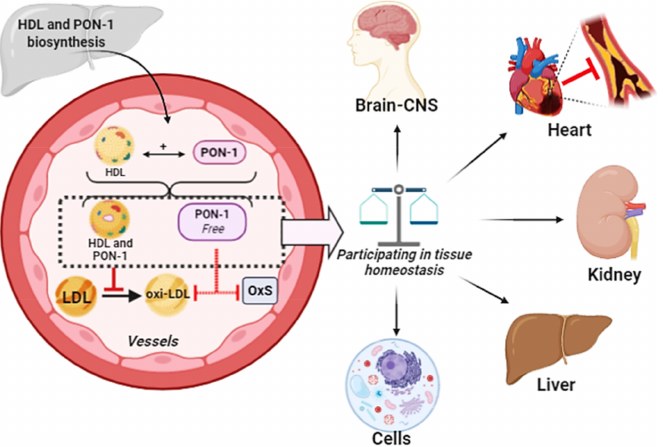
Figure 3. HDL biosynthesis occurs in the liver and in a small part of the intestine. Paraoxonase 1 (PON1) biosynthesis occurs only in the liver. After the formation of both HDL and PON1, they enter into the circulation. An association between HDL and PON1 can occur both in the hepatic circulation (to a lesser extent) and in the plasma. A small amount is free PON1, which do not adhere to any lipoprotein. An important function of PON1 is to prevent oxidation of both HDL and LDL, through the hydrolysis of reactive compounds. Oxidized LDL (ox-LDL) is pro-inflammatory and atherogenic. PON1 is carried to the tissues by HDL, where it performs its function as an antioxidant enzyme. In addition, the portion of free PON1 in the plasma also acts as an antioxidant, but its hydrolysis capacity is